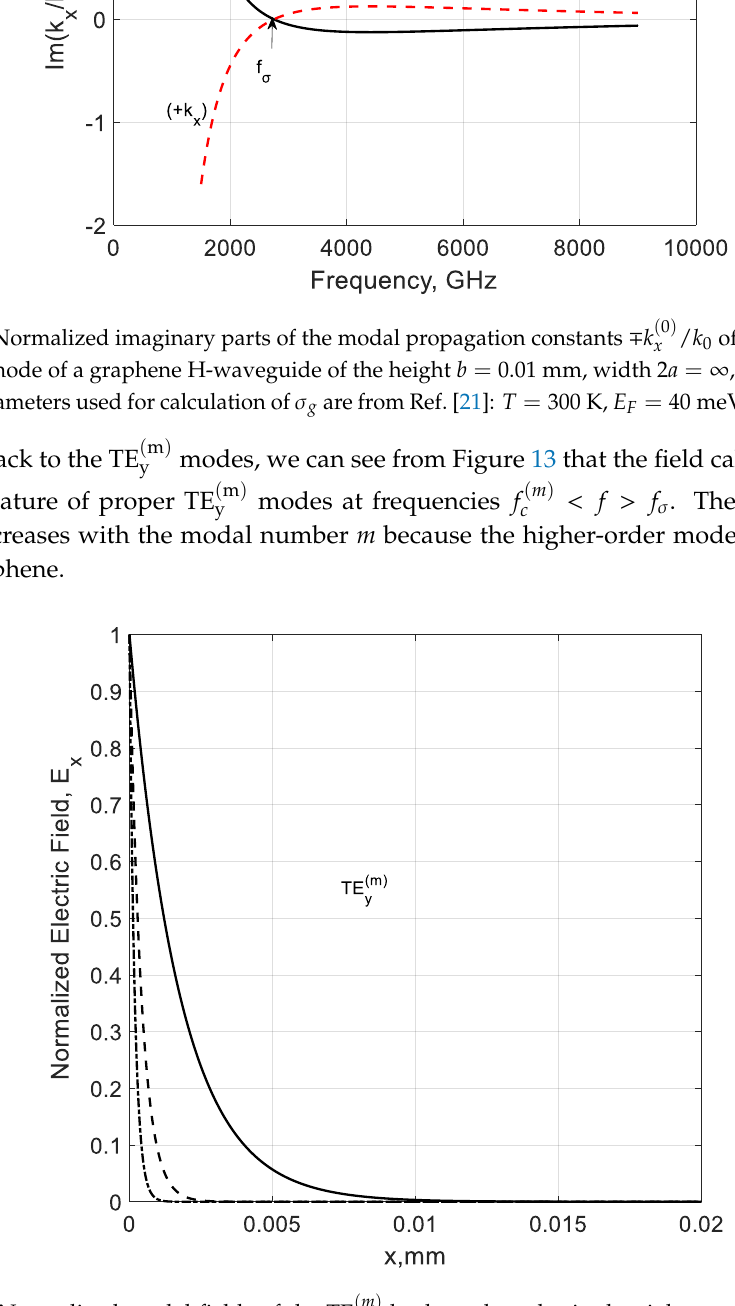
Figure 13. Normalized modal fields of the TE H-waveguide (Figure 1) of the height b = 0.01 mm and width 2 a = ∞ , ε r = 1, and µ r = 1 calculated at frequency f = 4000 GHz. Solid line: m = 1; dash line: m = 2; and dash-dot line: m = 3. Parameters used for calculation of σ g are from Ref. [21]: T = 300 K, E F = 40 meV, and τ = 1